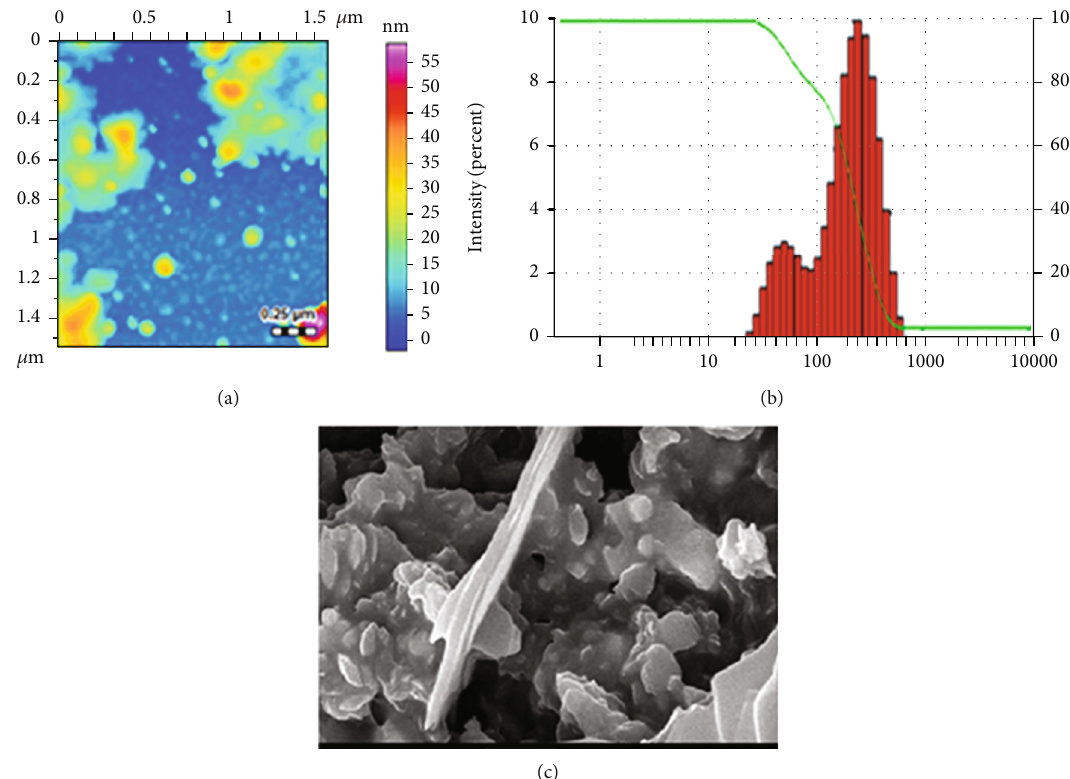
Figure 10: Change in surface morphology and size of ACR-AgNPs upon complex formation with Hg 2+ . (a) AFM image of ACR-AgNPs- Hg 2+ . (b) Change in particle size of ACR-AgNPs upon addition of Hg 2+ . (c) SEM image of ACR-AgNPs-Hg 2+ .